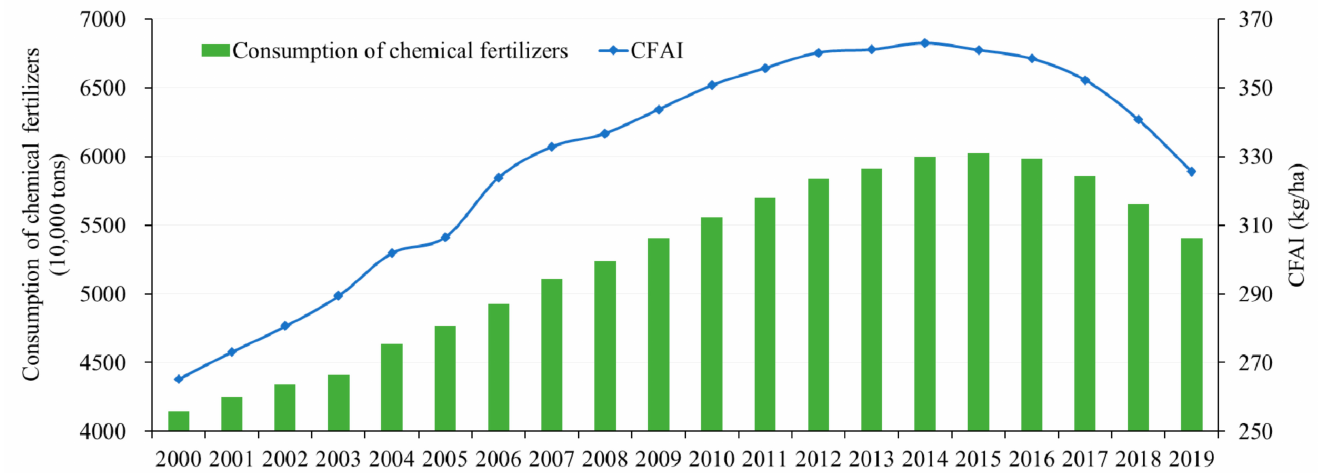
Figure 1. Evolution of chemical fertilizer application in China from 2000 to